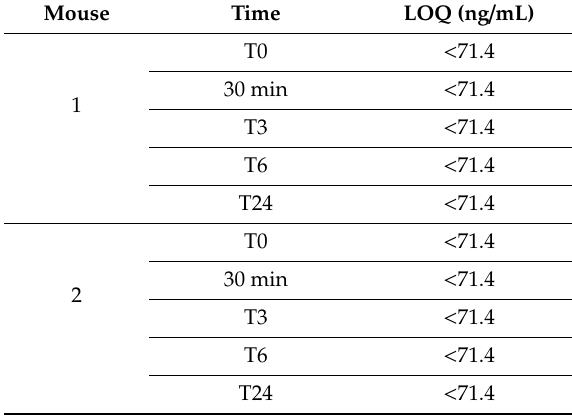
Table 1. In vivo Adelmidrol absorption . Adelmidrol absorption: all serum levels of Adelmidrol were less than limit of quantification